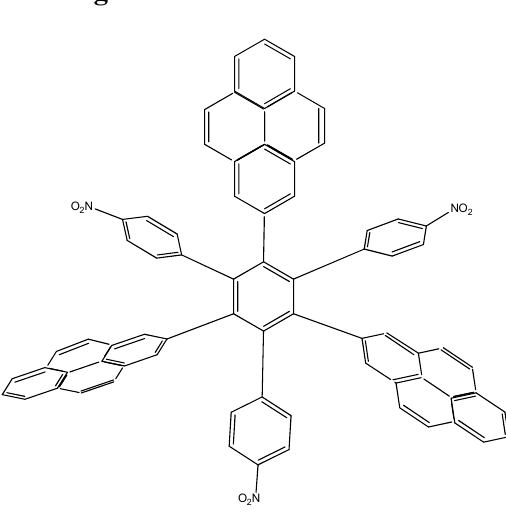
Figure 16. Structure of HAB8